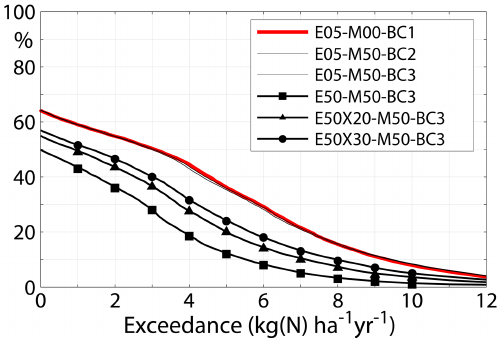
Figure 12. Frequency distribution of exceedances of the critical lev- els for eutrophying nitrogen in Europe (EU28 + ) . The red line (E05- M00-BC1) represents a year 2000 base case and the E50-M50-BC3 scenario represents year 2050 with current emission estimates. The E50X20 and E50X30 scenarios illustrate calculations with 20 and 30% extra NH 3 emission due to climate-induced evaporation. See Simpson et al. (2014) for more